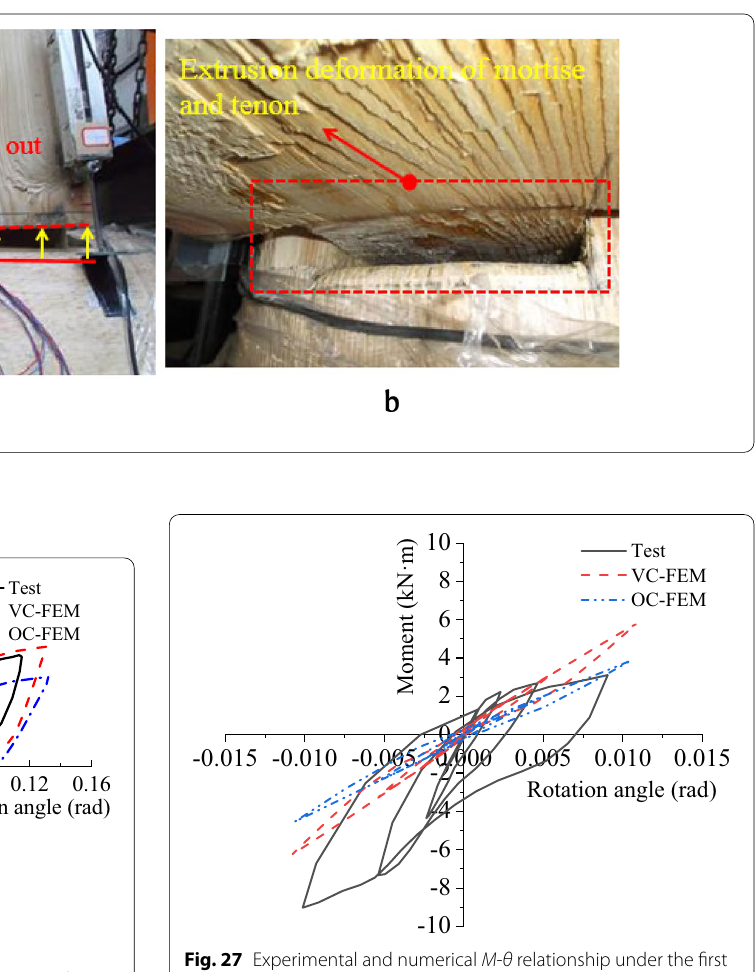
Fig. 25 Comparison of M - θ relationship at the first primary cycle with different control displacements